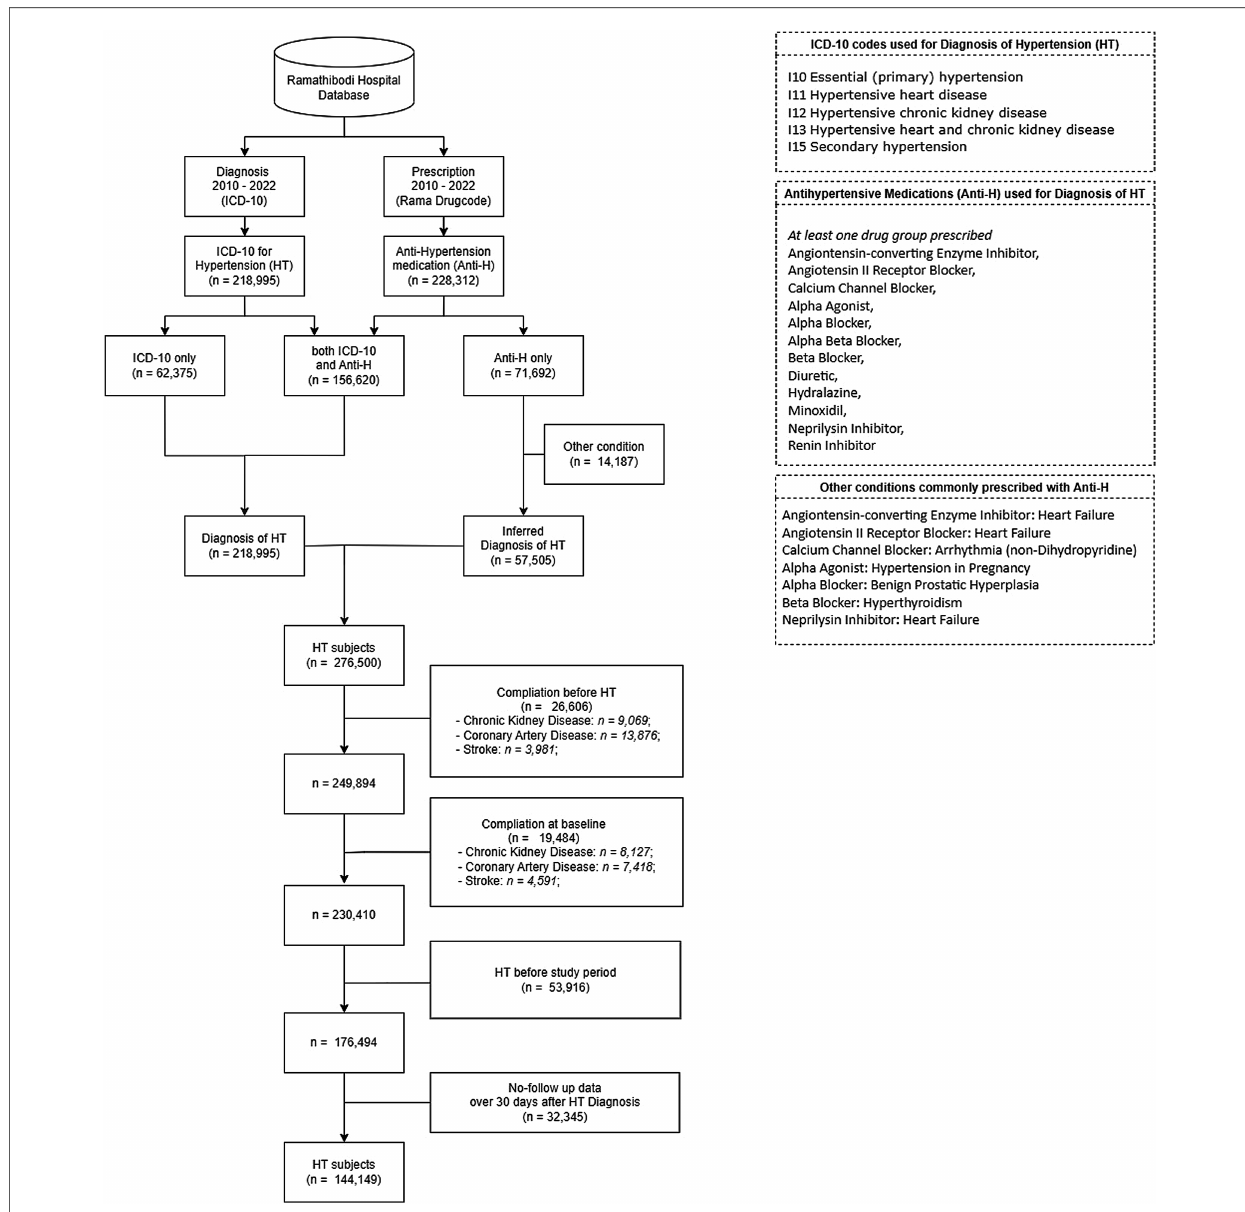
FIGURE 1 Data retrieval and processing fl